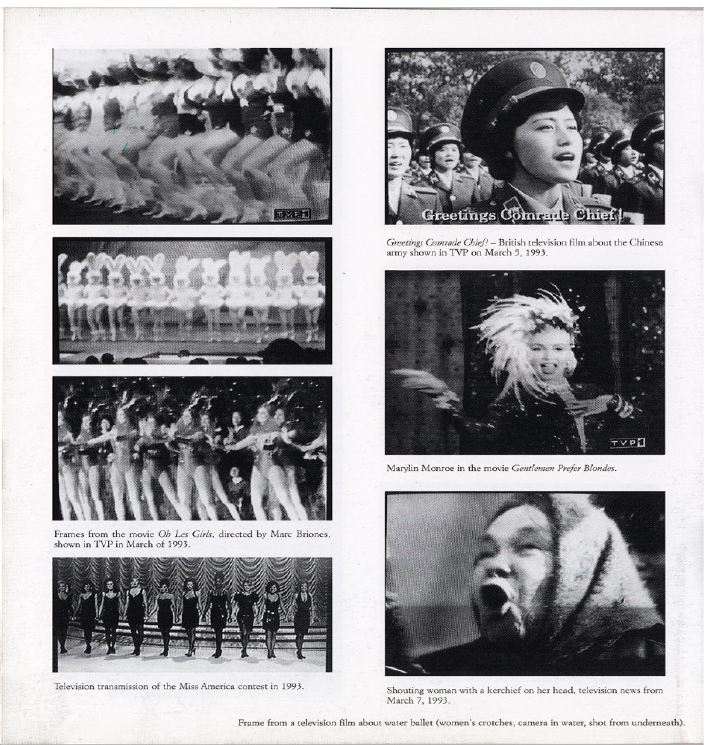
Figure 7. Kulik, guide, 1997. Female elements.